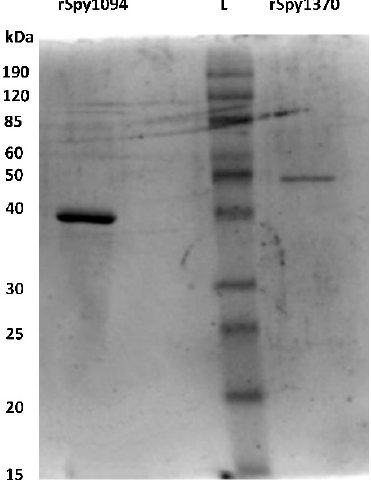
Figure 1. Purified recombinant Spy1094 and rSpy1370. The proteins were expressed in E. coli as thioredoxin fusion proteins and purified by immobilised metal chelate affinity chromatography (IMAC) using an NTA-Ni 2+ resin. Thioredoxin was cleaved-off with 3c protease and removed by passing the solution over NTA-Ni 2+ again. The purified proteins were run on a 12.5% SDS PAGE gel and have an estimated purity of >90%.